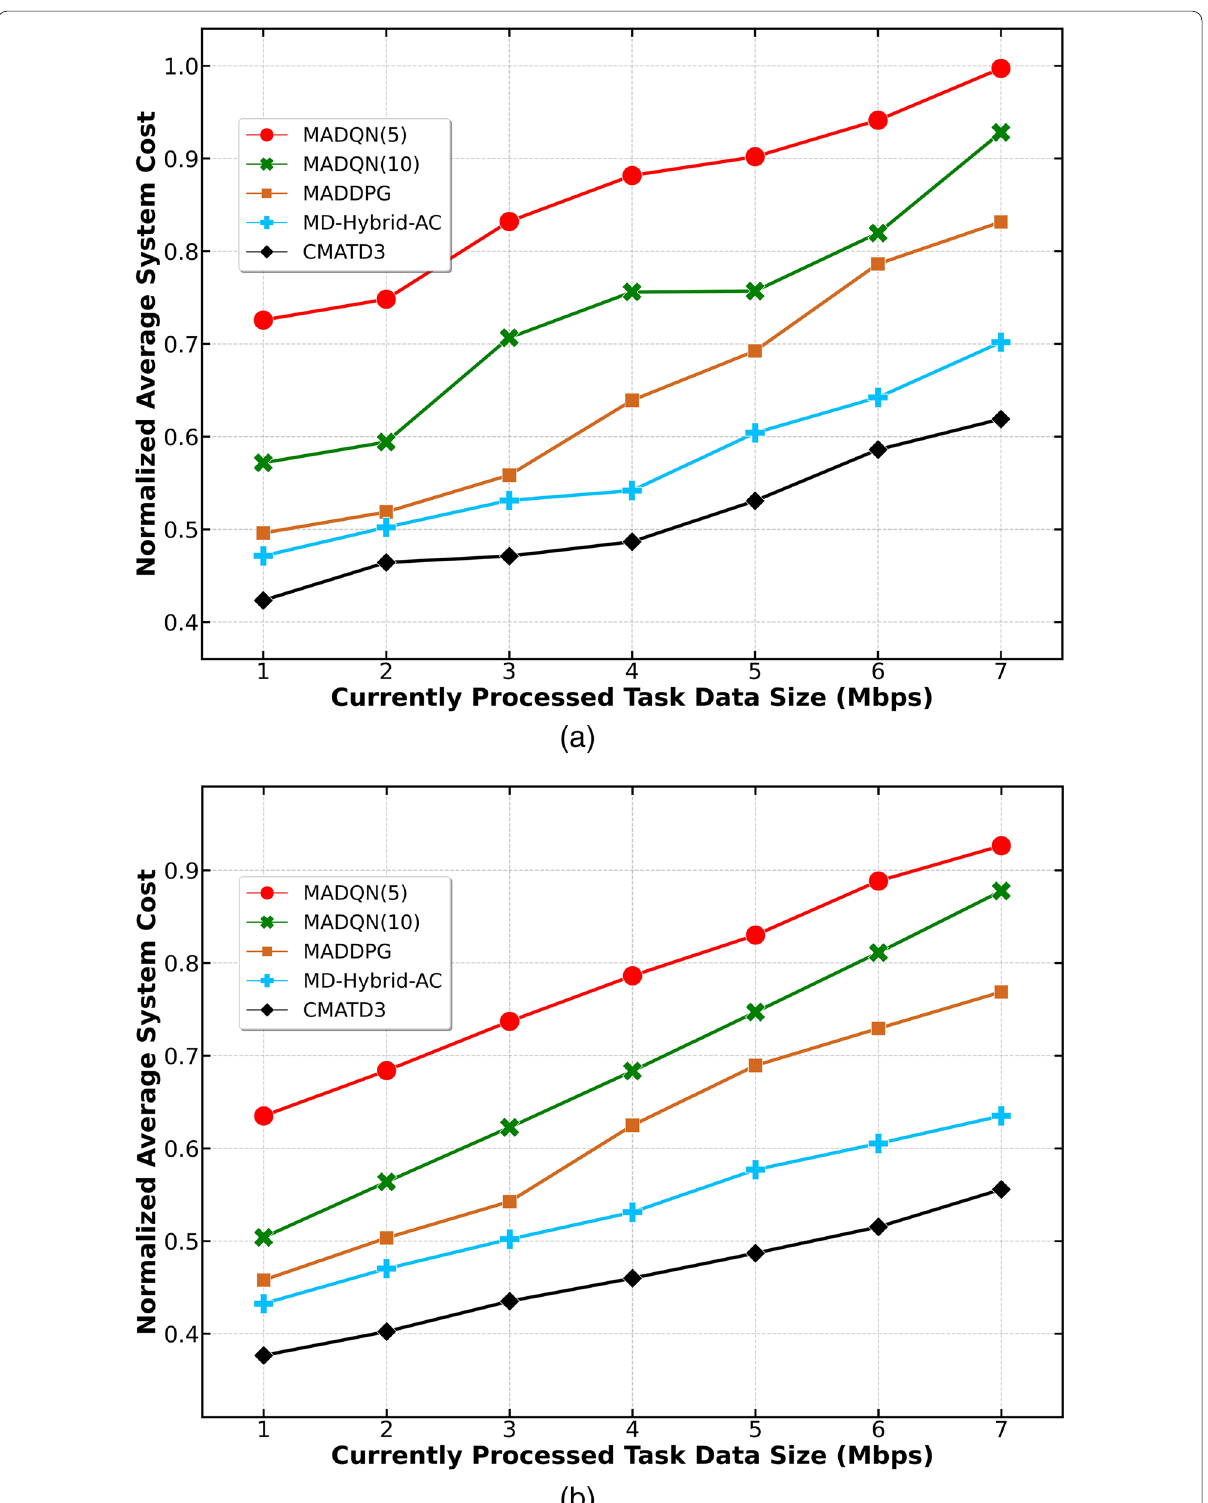
Fig. 8 Results of normalized average system cost vs. d t m . with a the number of cloud server M = 2 and b the number of cloud server M =